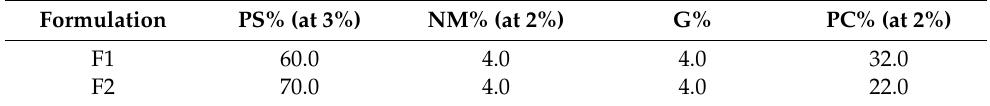
Table 1. Formulation of